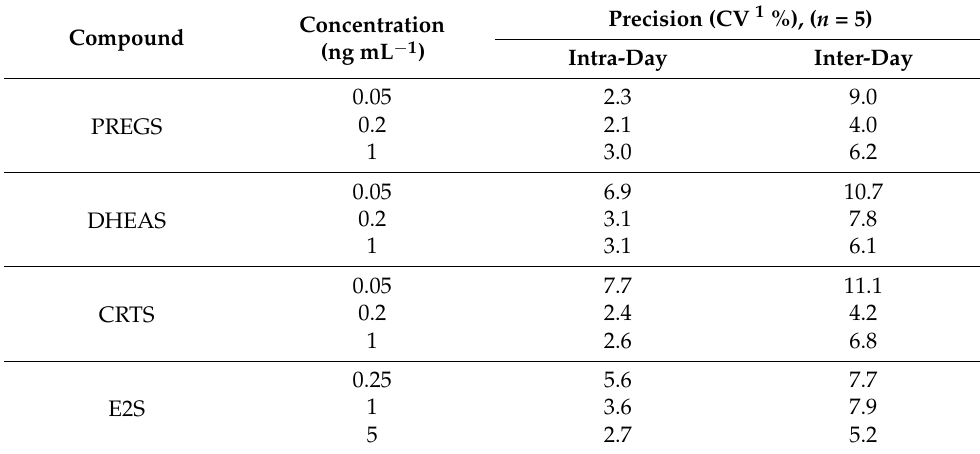
Table 2. Precision of the IT-SPME LC–MS/MS method for sulfated steroid